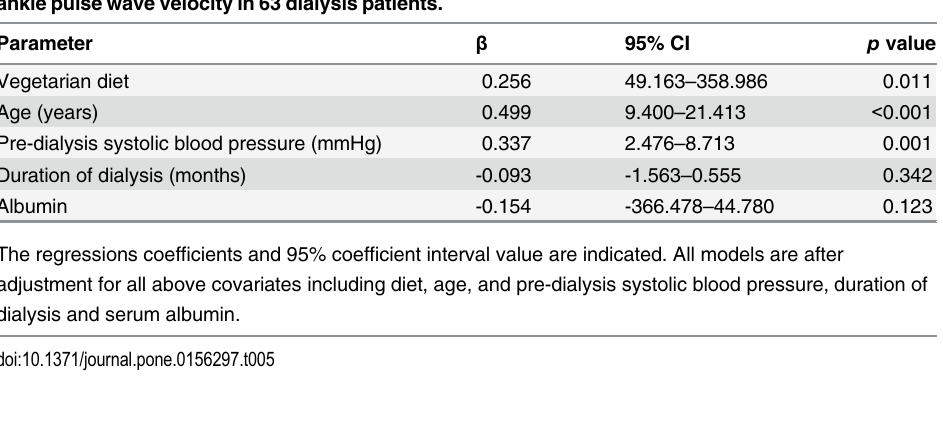
Table 5. Output from multiple stepwise regression analyses between multiple factors and brachial- ankle pulse wave velocity in 63 dialysis patients.